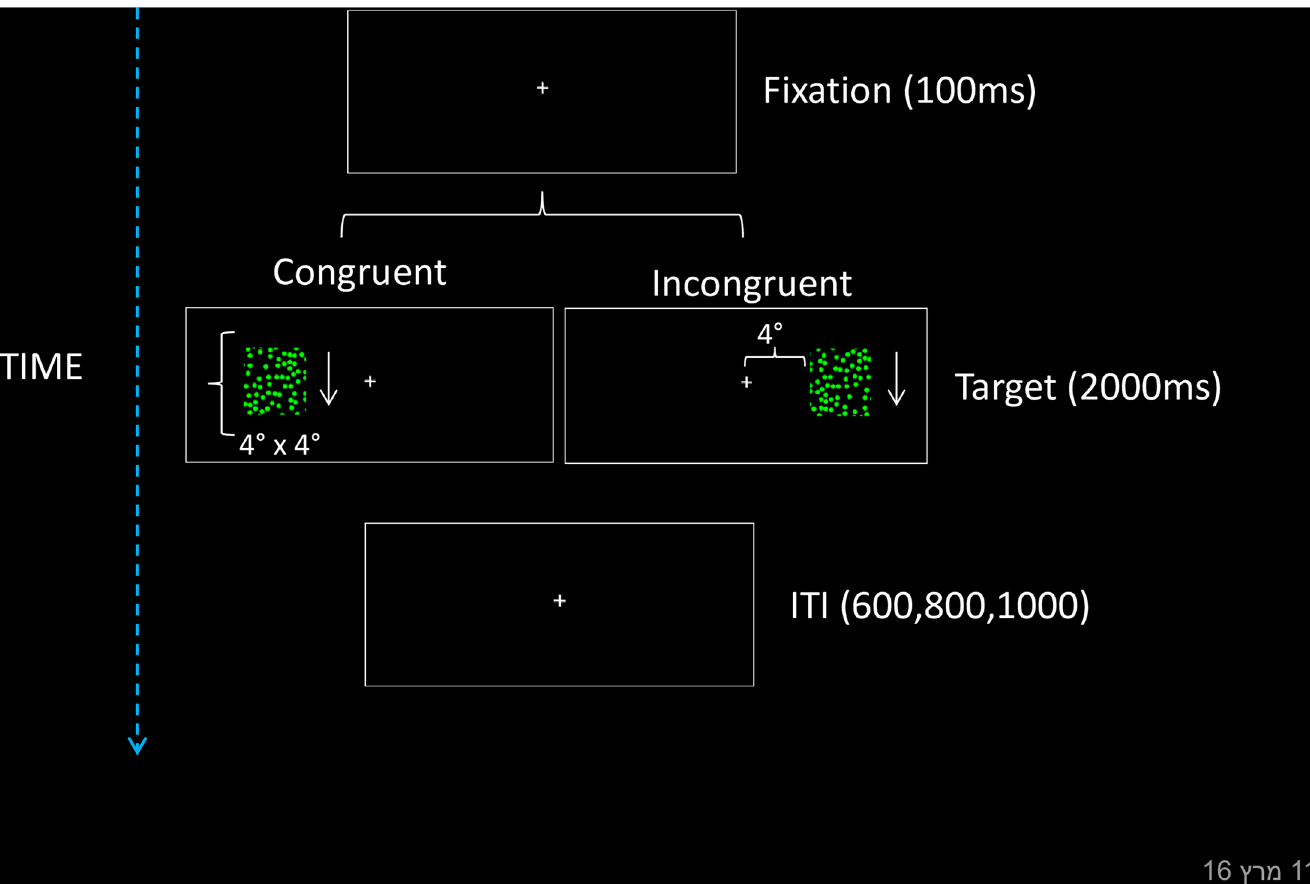
Fig 1. Layout and timing of the task. In different trials, a flowfield of moving dots was presented in the left or right visual field. Motion direction was mapped with left and right responses. Following the example given here, when a downward motion target is mapped with left responses and the target appears in the left visual field, the trial is compatible; when upward motion appears in the left field the trial is